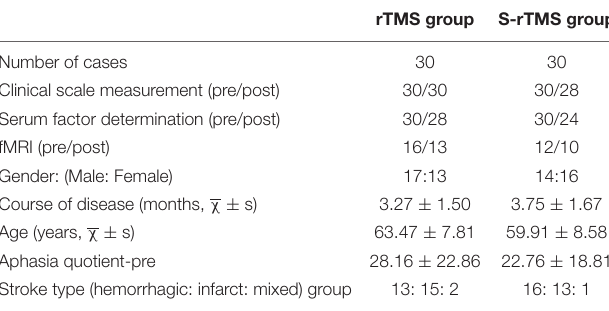
TABLE 1 | General information of the enrolled